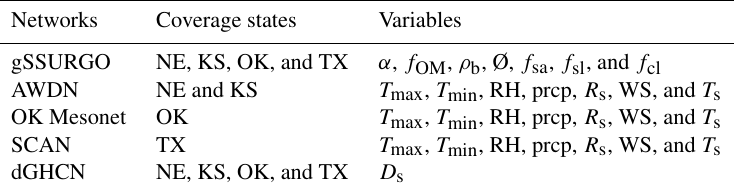
Table A2. List of data sets used in this study, including the data source (Networks), state names (Coverage states), and specific data vari- ables (Variables). Data sources include the Gridded Soil Survey Geographic (gSSURGO), the Automated Weather Data Network (AWDN) – High Plains Regional Climate Center (HPRCC), the Oklahoma Mesonet (OK Mesonet), the Soil Climate Analysis Network (SCAN), and the daily Global History Climatology Network (dGHCN). Weather stations from four states were located in the USA Great Plains, includ- ing Nebraska (NE), Kansas (KS), Oklahoma (OK), and Texas (TX). Climate data report the daily maximum ( T max ; degrees Celsius) and minimum air temperature ( T min ; degrees Celsius) at 2m height, relative humidity (RH; percent), rainfall (prcp; millimeters), solar radiation ( R s ; MJm − 2 d − 1 ), wind speed at 2m (WS; meters per second), and snow depth ( D s ; millimeters). Soil data consist of the daily bare soil temperature at 10cm depth ( T s ; degrees Celsius), albedo of soil surface ( α ; –), organic matter content ( f OM ; percent), bulk density ( ρ b ; grams per cubic meter), porosity (Ø; percent), sand ( f sa ) , silt ( f sl ), and clay ( f cl ) content